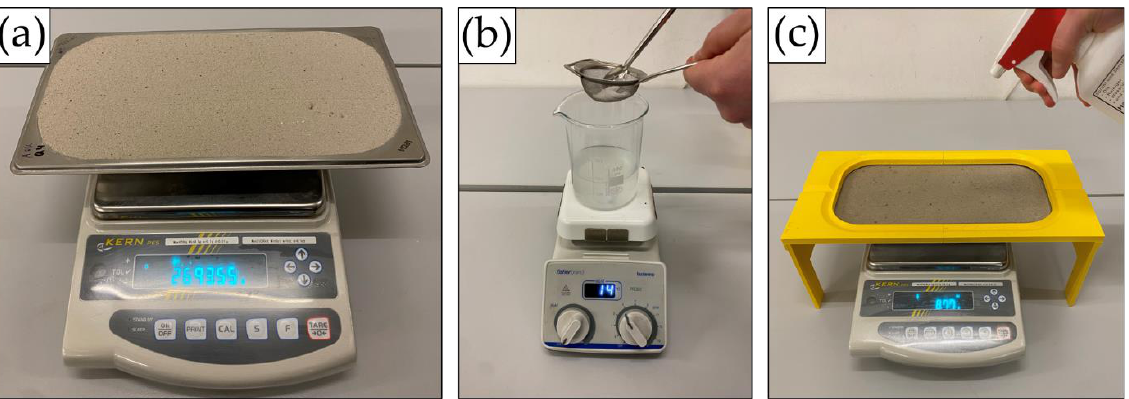
Figure 1. Sample preparation. ( a ) Weighing of dry sample, ( b ) preparation of biopolymer solution, and ( c ) gravimetric spray-on application with splash guard.